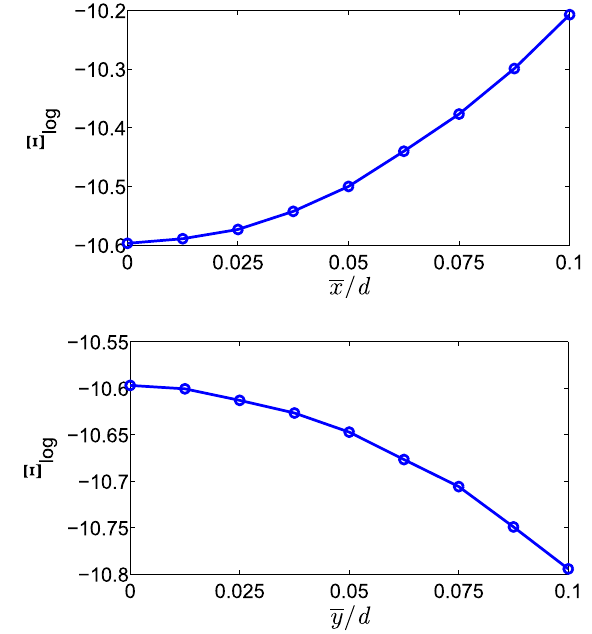
regarding the log ratio method; log